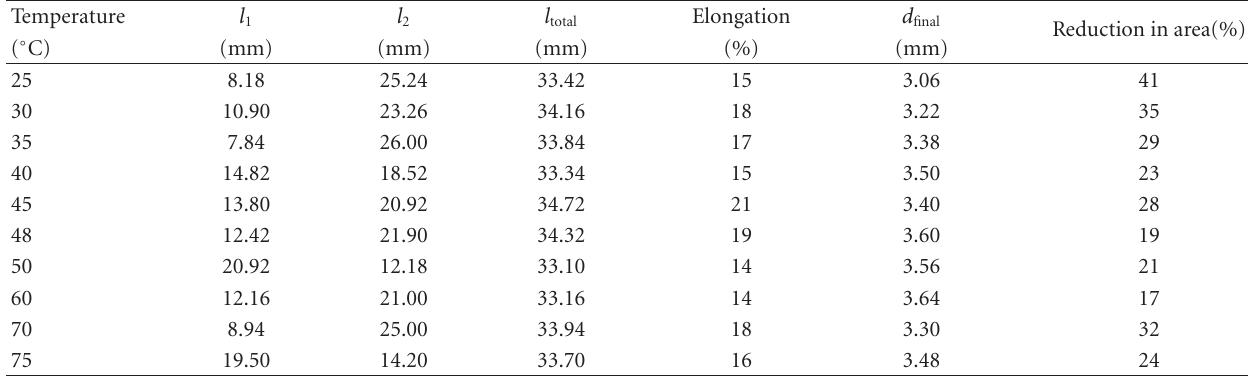
Table 4: Temperature-dependent results of samples machined perpendicular to the rolling direction and tested in 50% CO–50% CO 2 .